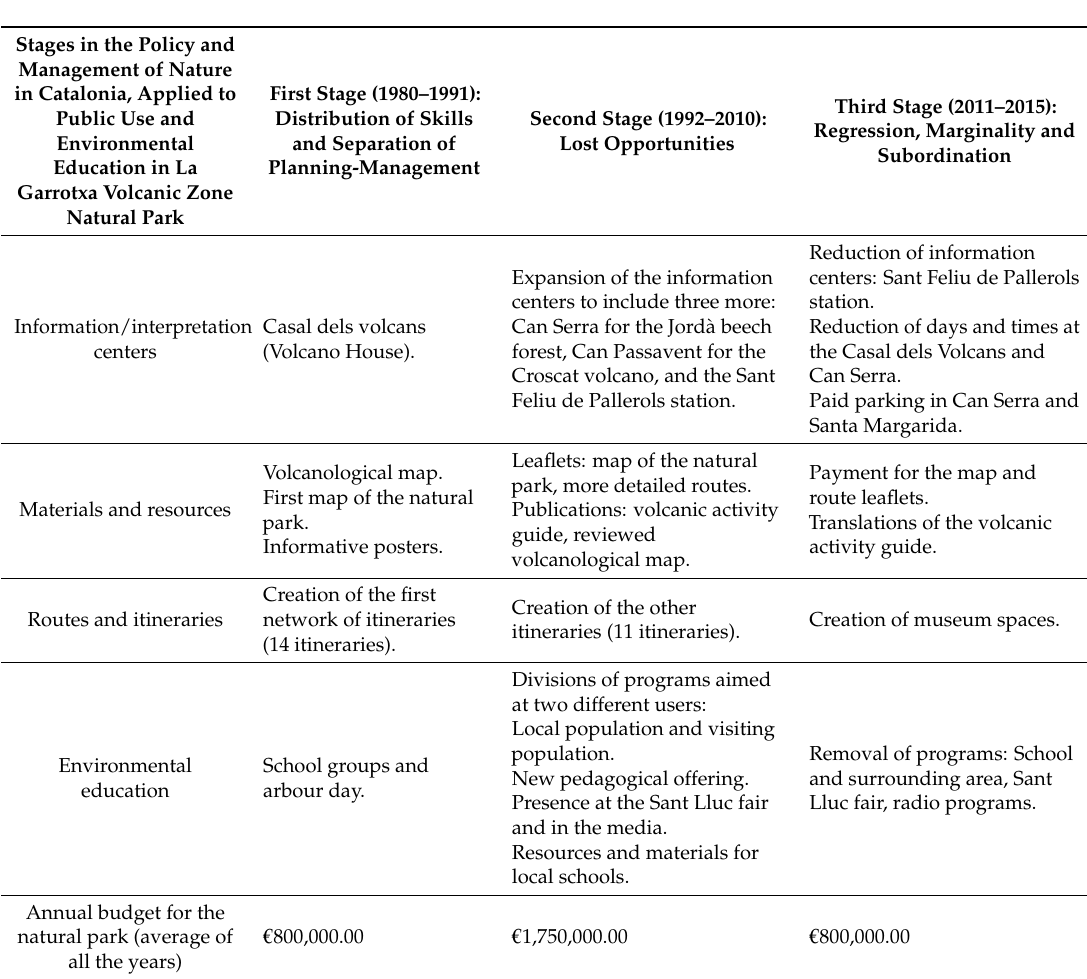
Table 2. How policies related to the natural heritage of the government of Catalonia have affected La Garrotxa volcanic zone natural park. Adapted from Casademunt 2018